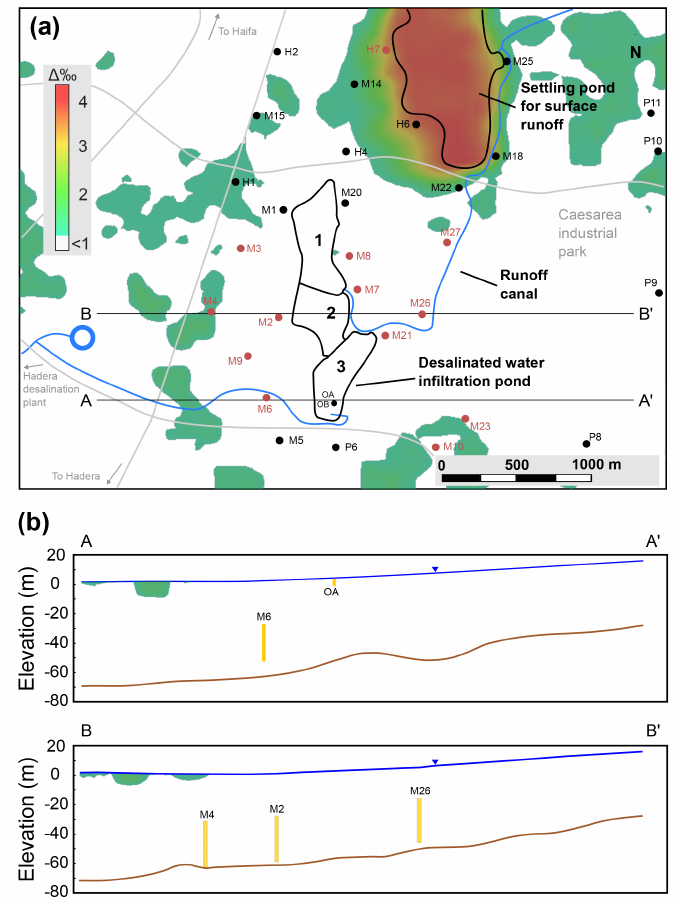
Figure 6. Examination of the validity of the assumption of binary isotopic mixing. (a) Plan view (water table) of δ 2 H difference ( (cid:49) ‰) between simulation results (2015–2017) with δ 2 H max =− 18.41‰ (C GW = 0 . 13) and δ 2 H min =− 22.68‰ (C GW = 0) at the end of 2017; the white area indicates (cid:49) ‰<1. (b) East–west cross sections through wells OA and M6 (A-A (cid:48) ) and wells M4, M2 and M26 (B-B (cid:48) ); well screens are shown in